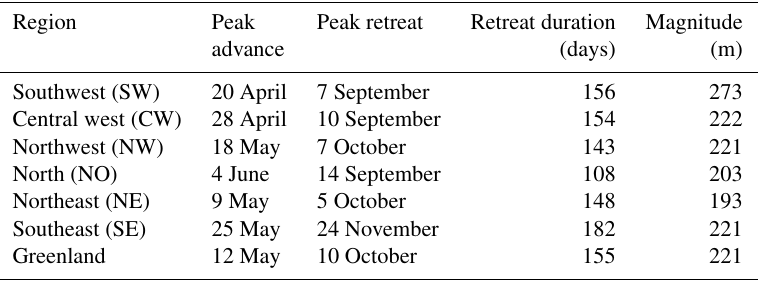
Table 3. Regional breakdown of the timing and magnitude of terminus-position seasonality. All reported values are medians across the set of glaciers in a given region. To contextualize the magnitudes, note that the terminus digitization uncertainty is typically ∼ 25m.